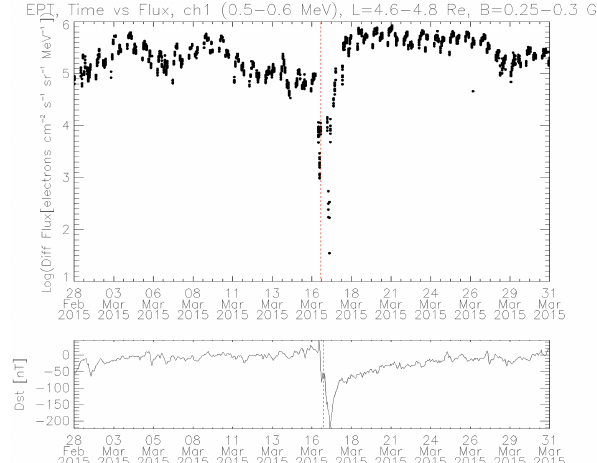
Figure 3. Electron fluxes observed by EPT/PROBA-V in Channel 1 (500–600keV) and in bin 4 . 6 <L< 4 . 8, 0 . 25 <B< 0 . 3G as a func- tion of time between 1 and 31 March 2015. A dropout is clearly visible during the main phase of the 17 March storm.